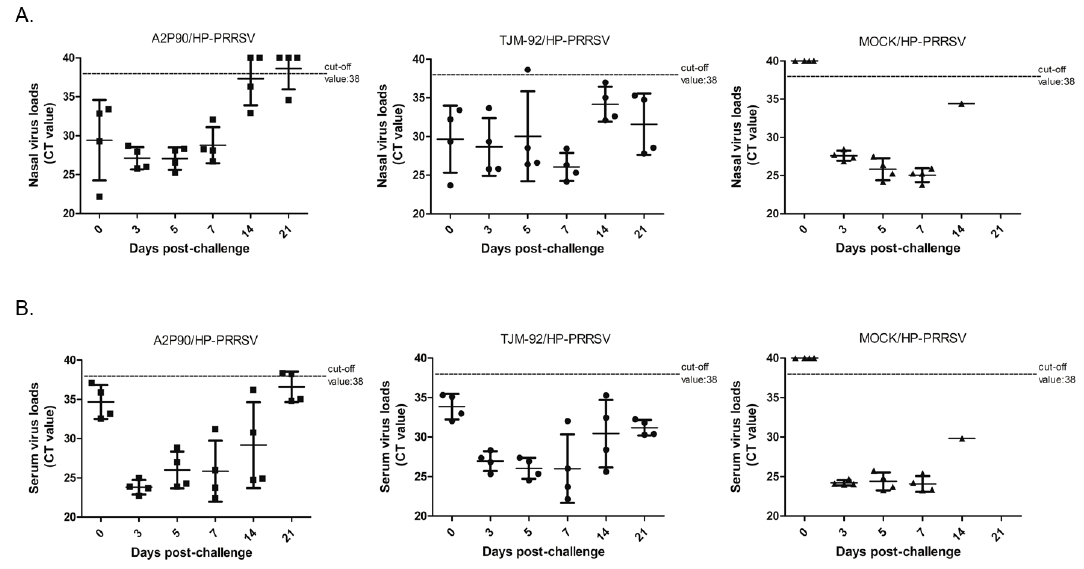
Figure 4. PRRSV-A2MC2-P90 vaccination reduced nasal shedding of virus and viremia after HP-PRRSV challenge of vaccinated piglets. ( A ). Nasal swab samples collected at indicated time points and harvested using TRIzol reagent were subjected to PRRSV RNA detection using IDEXX RealPCR PRRSV-2 RNA Mix. The Ct value of each sample is presented for comparison and was based on the manufacturer cut-off Ct value of 38. ( B ). Serum samples collected from each piglet at indicated time points and processed using TRIzol reagent were subjected to PRRSV RNA detection using IDEXX RealPCR PRRSV-2 RNA Mix. The Ct value of each sample is presented for comparison and was determined based on the manufacturer cut-off the Ct value of 38.